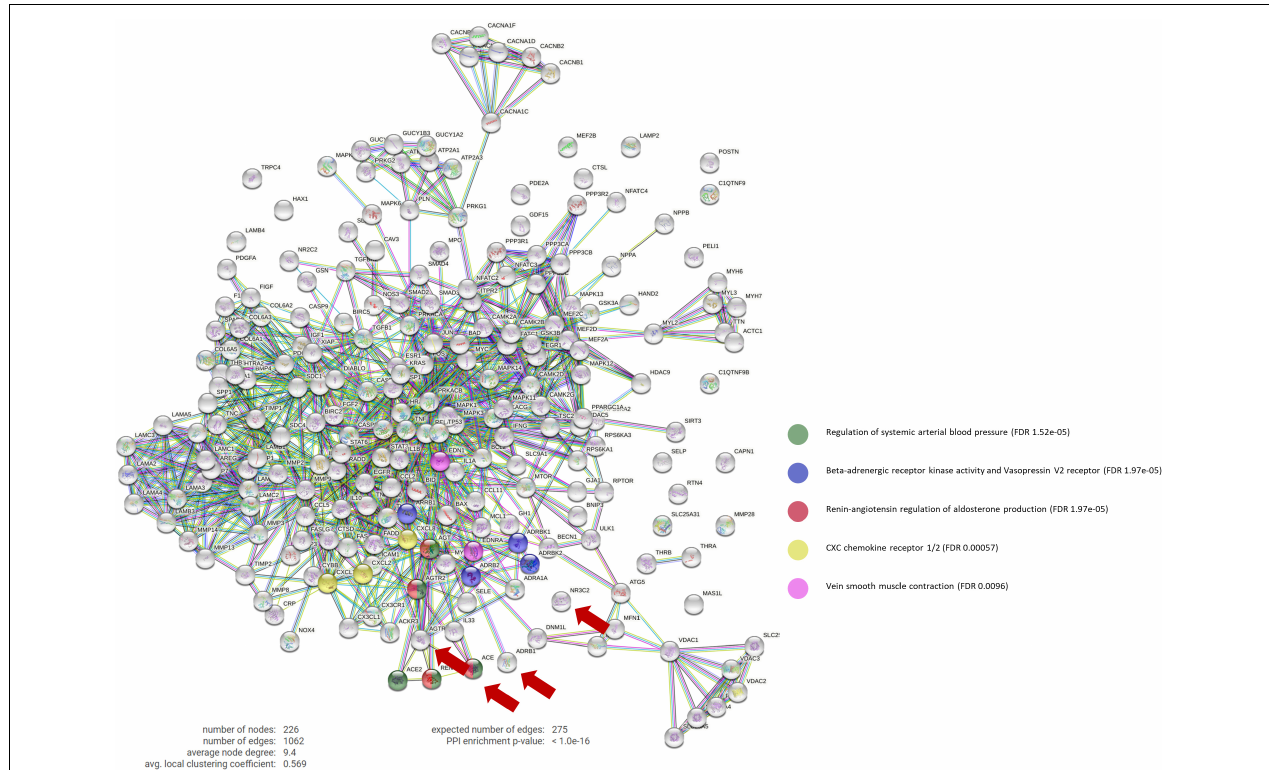
FIGURE 1 | Protein-Protein interaction network. PPi network that contains the interactions between the main targets of ACEi, BB, MRA, and ARB treatments (ACE1, ADRB1, NR3C2, and AGTR1, respectively) and our curated molecular characterization of post-MI remodeling (which includes 222 proteins). BB main effect involve the Beta-adrenergic receptor kinase activity and vasopressin V2 receptor biological pathways (in blue), which include GPRK2 modulation. Number of nodes: 226; Number of connections: 1,062; Expected number of random connections: 275; PPi Enrichment p -value: < 1.0e-16; PPi, Protein-protein interaction; ACEi, angiotensin converting enzyme inhibitors; BB, beta-blockers; MRA, mineralocorticoid receptor antagonists; ARB, angiotensin receptor